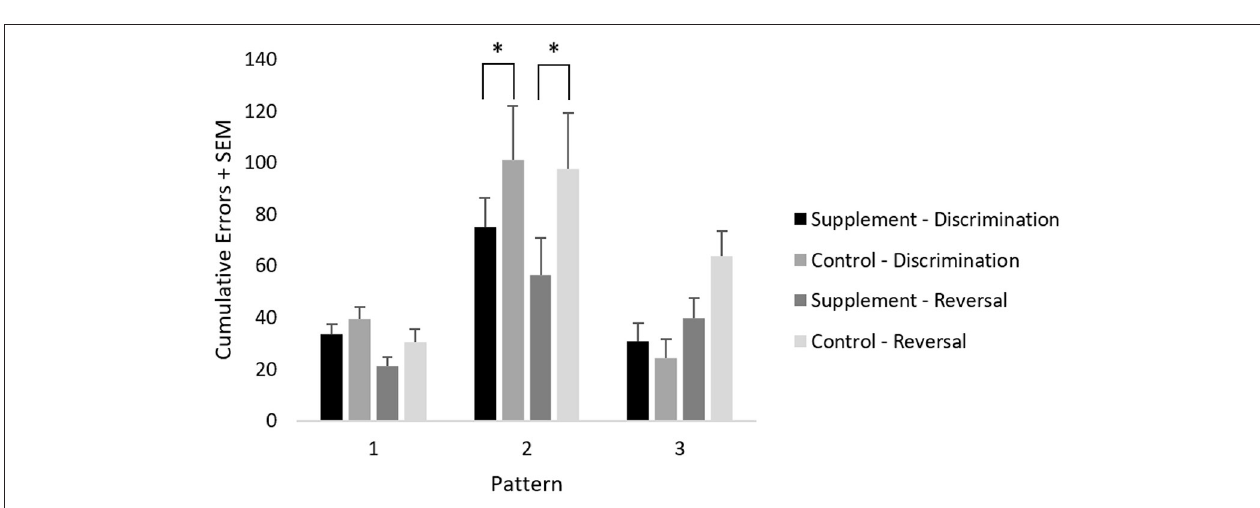
FIGURE 5 | Mean cumulative errors on spatial discrimination across patterns and test phases. An * represents significantly lower errors ( p = 0.01) in the supplement group compared to the control group on pattern 2, independently of task